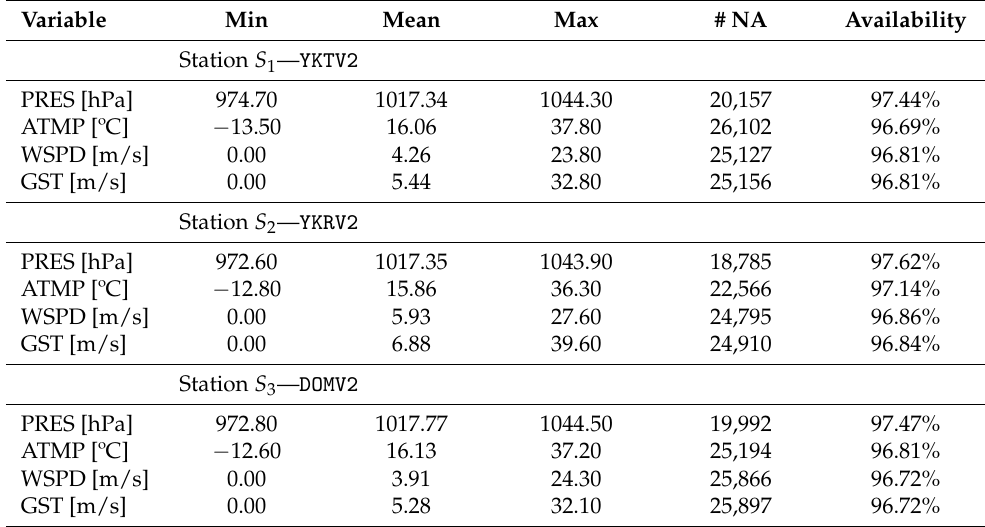
Table 2. Data availability in the meteorological